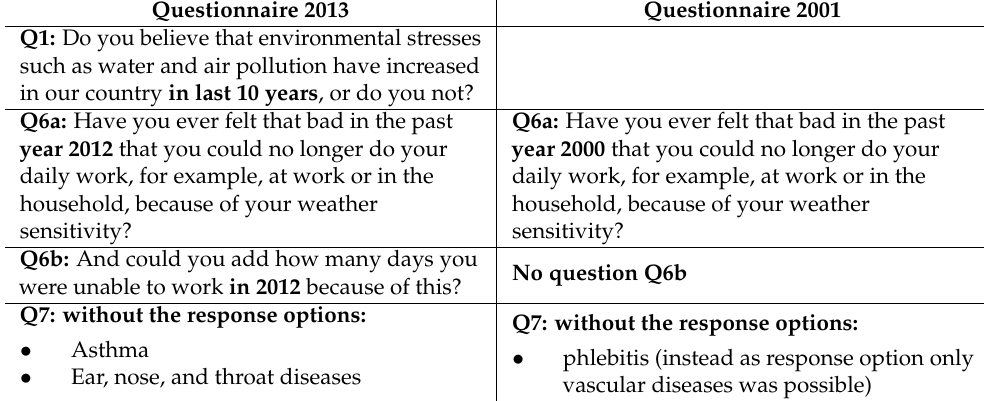
Table A2. Changes to questionnaires in 2013 and 2001 compared to questionnaire 2021 (Table A1). Questionnaire 2013